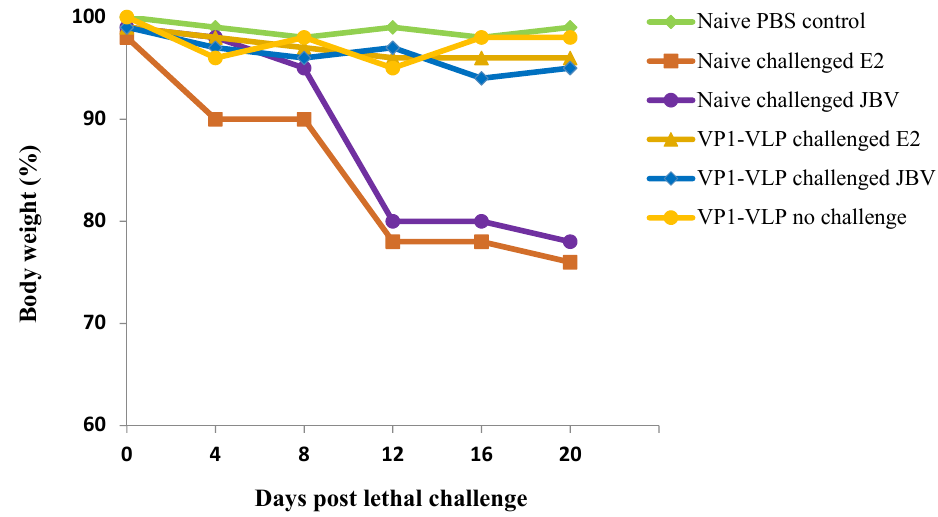
Figure 7. Body weight changes observed in all mice groups at different days post lethal challenge with pathogenic E2 and JBV strains. Mice groups not immunized and challenged by pathogenic strains showed substantial decrease in body weight percentage. PBS naïve mice group represents the control group.